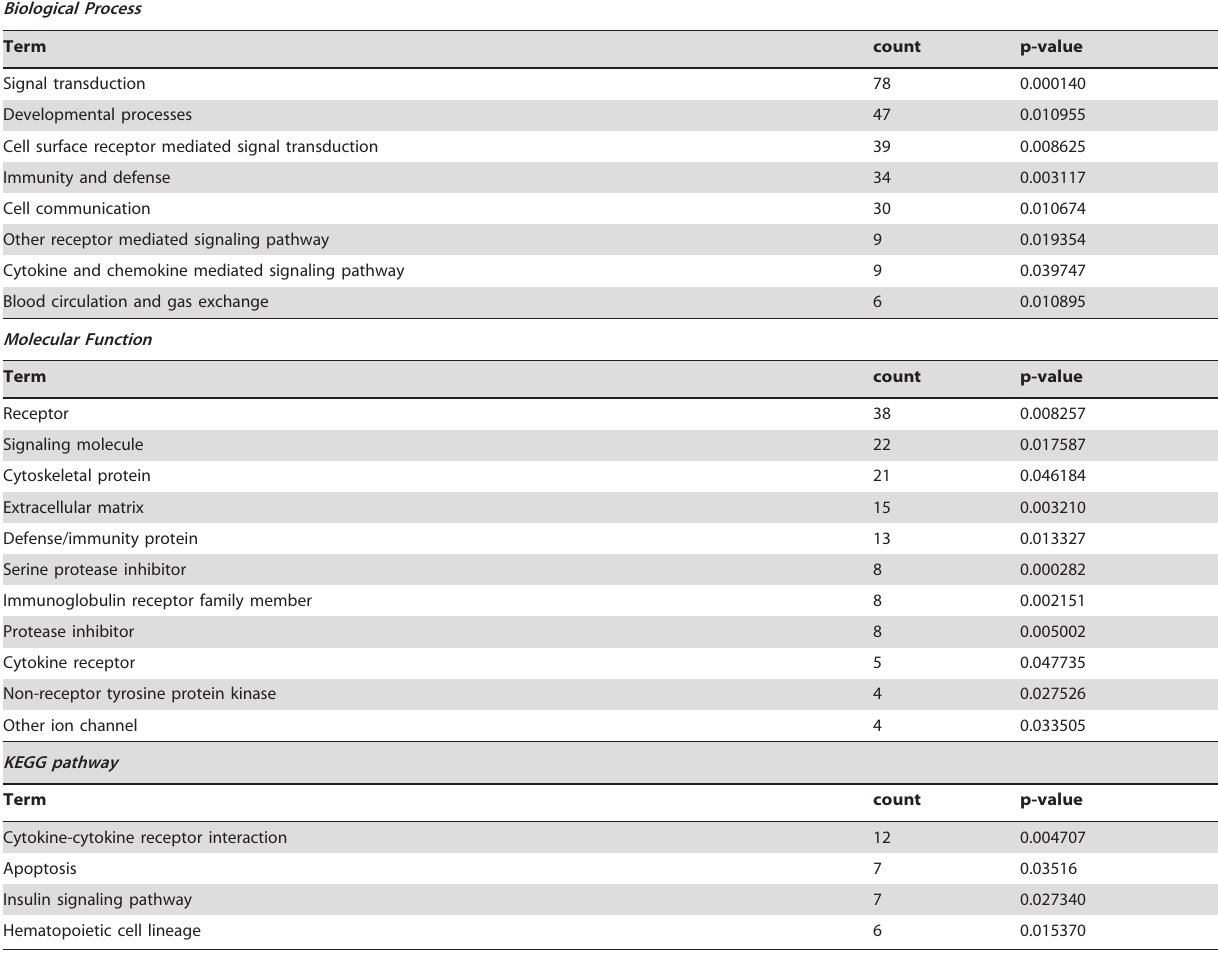
Table 2. Hypermethylation in choESC compred to